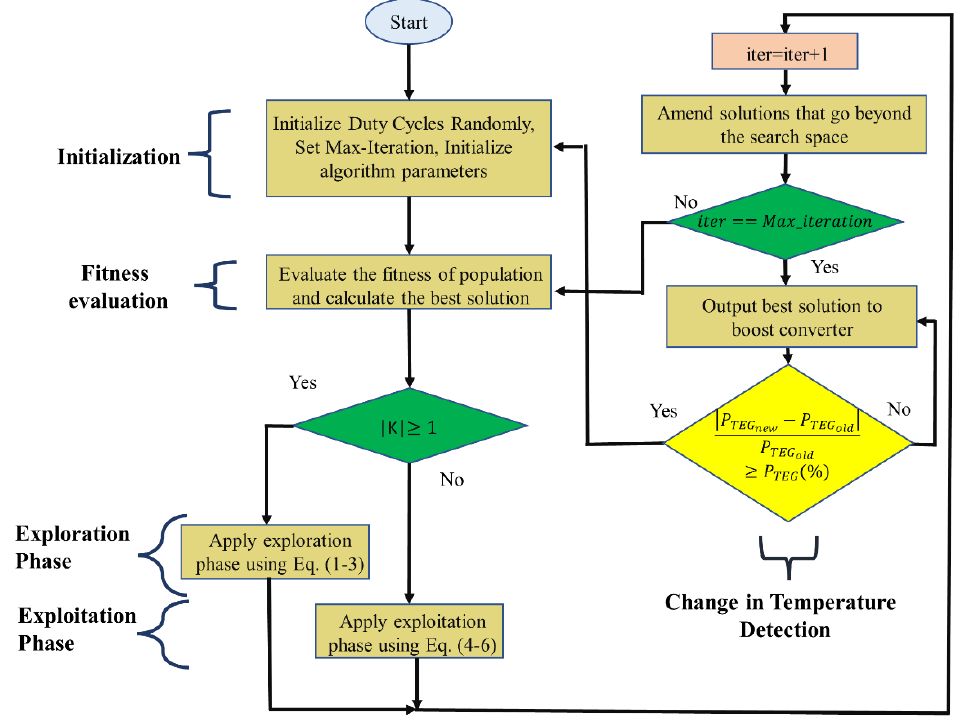
Figure 6. Flow chart of MRA.